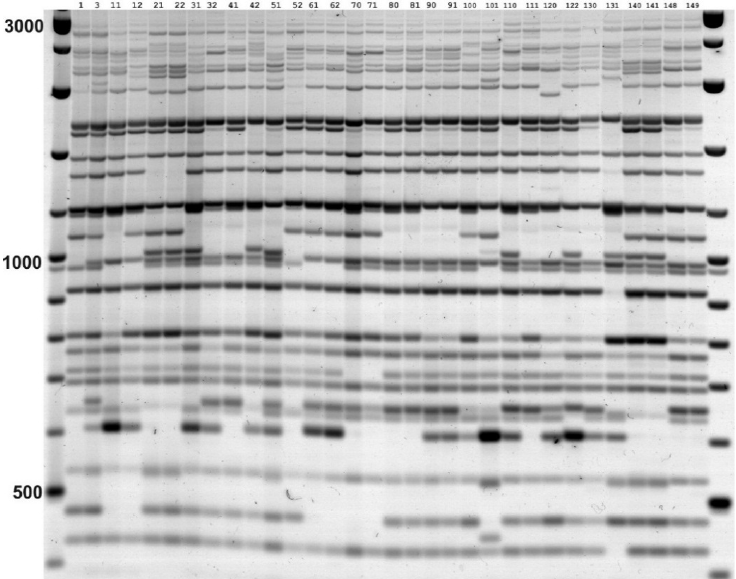
Figure 2. An IRAP gel produced with primer 679 (Sukkula LTR). DNA samples of the WEW